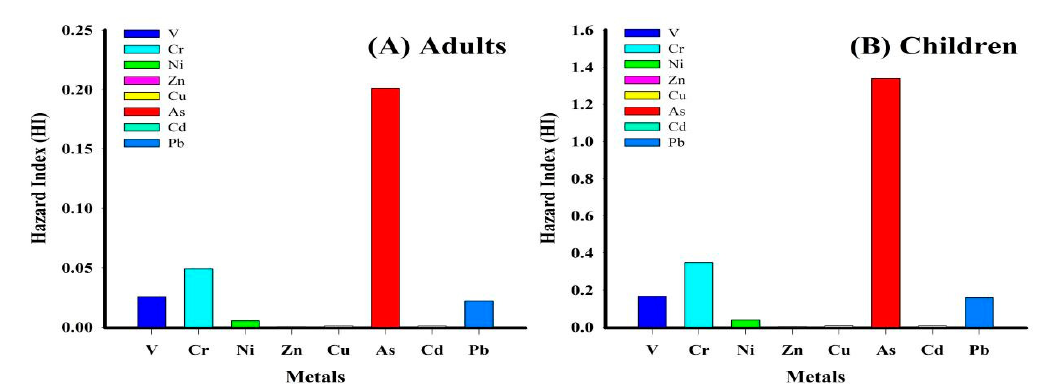
Figure 4. The metals HI: ( A ) adult; ( B ) child.